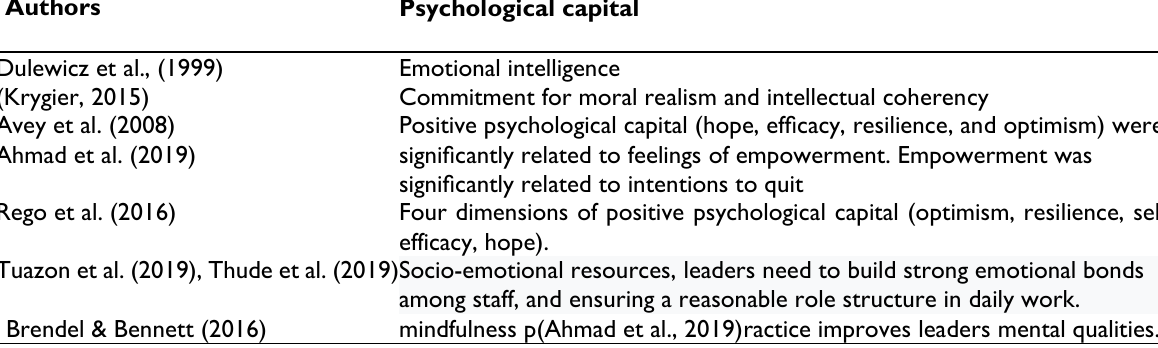
Table 7: Psychological Capital Authors